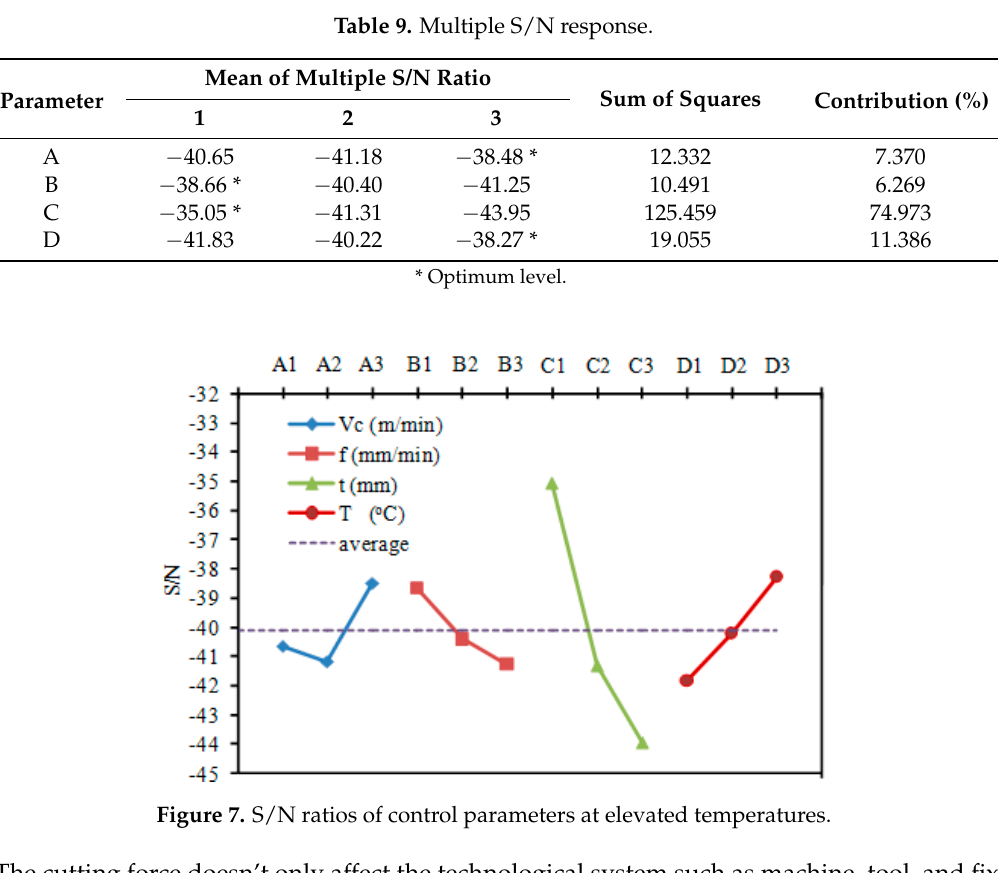
Table 10. Comparison of cutting force in conventional and thermal-assisted machining.